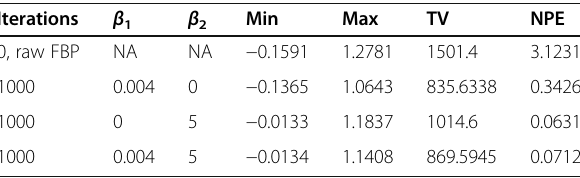
Table 1 Values of maximum, minimum, metal-free region TV, and NPE in reconstructions of bag #1